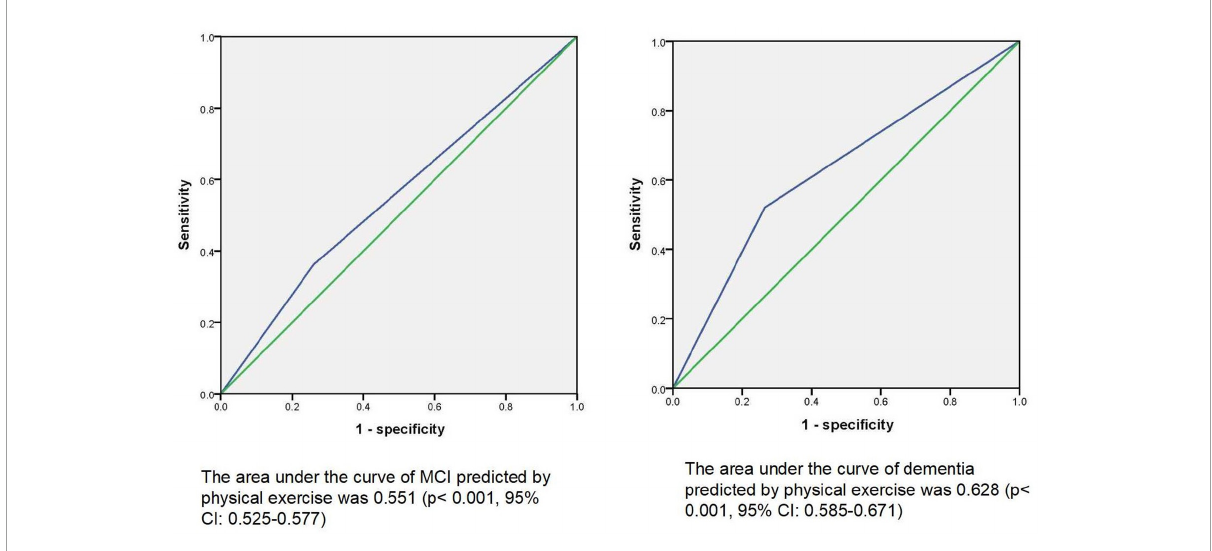
FIGURE1 ROC curve of physical exercise predicting cognitive